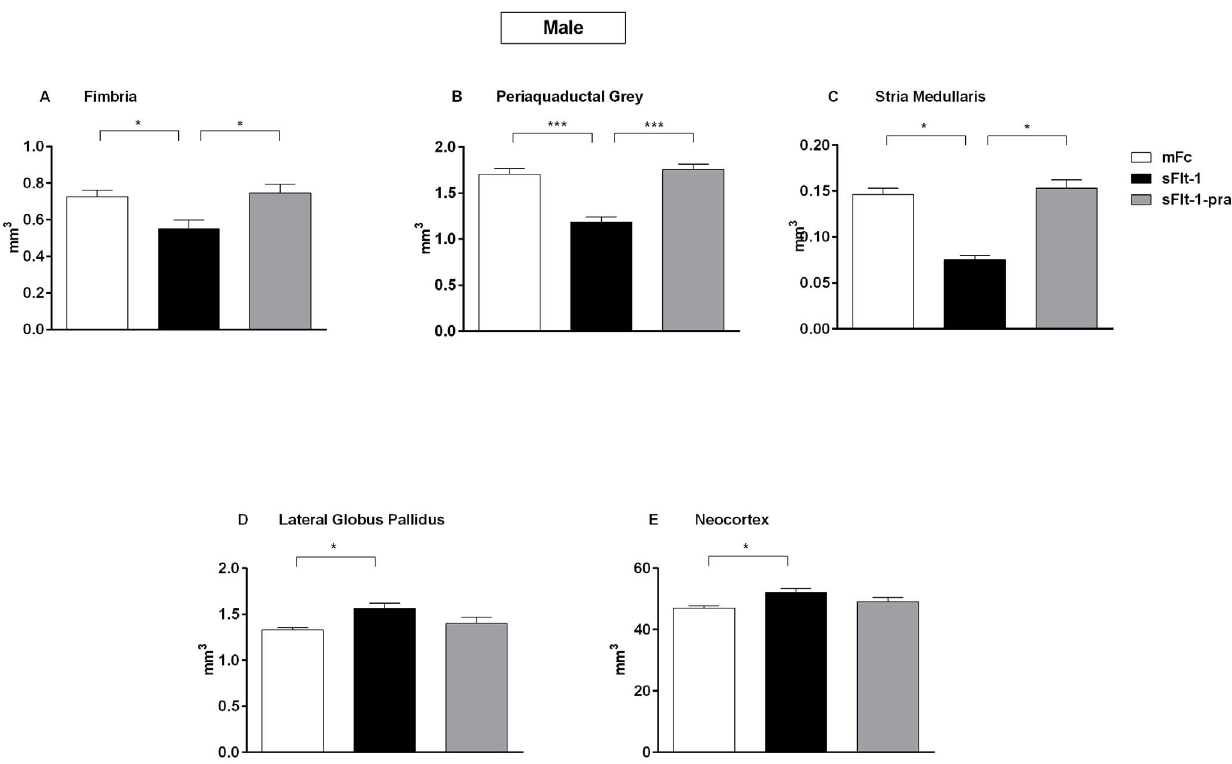
Figure 1. Altered Brain Volumes in 6 Month Old Male Offspring Brain. Regions of interest were analyzed by 1-way ANOVA in 6 month old male mice offspring born to pregnant CD1 mice injected either with an adenovirus carrying sFlt-1 or adenovirus carrying mFc fragment. Mice injected with sFlt-1 were treated with either pravastatin or water to result in three groups of offspring animals: mFc (n=9), sFlt-1 (n=3), and sFlt-1-pra (n=6). Data are reported as mean 6 SEM. The sFlt-1 group offspring showed decreased volumes at the fimbria (A; p=0.04), periaqueductal grey (B; p , 0.0001), and stria medullaris (C; p , 0.0001) when compared to the mFc control offspring. Increased volumes were seen at the lateral globus pallidus (D; p=0.01) and neocortex (E; p=0.02). The overall ameliorative effect of pravastatin exposure in utero is seen. Not shown are brain regions with similar volumes between groups.